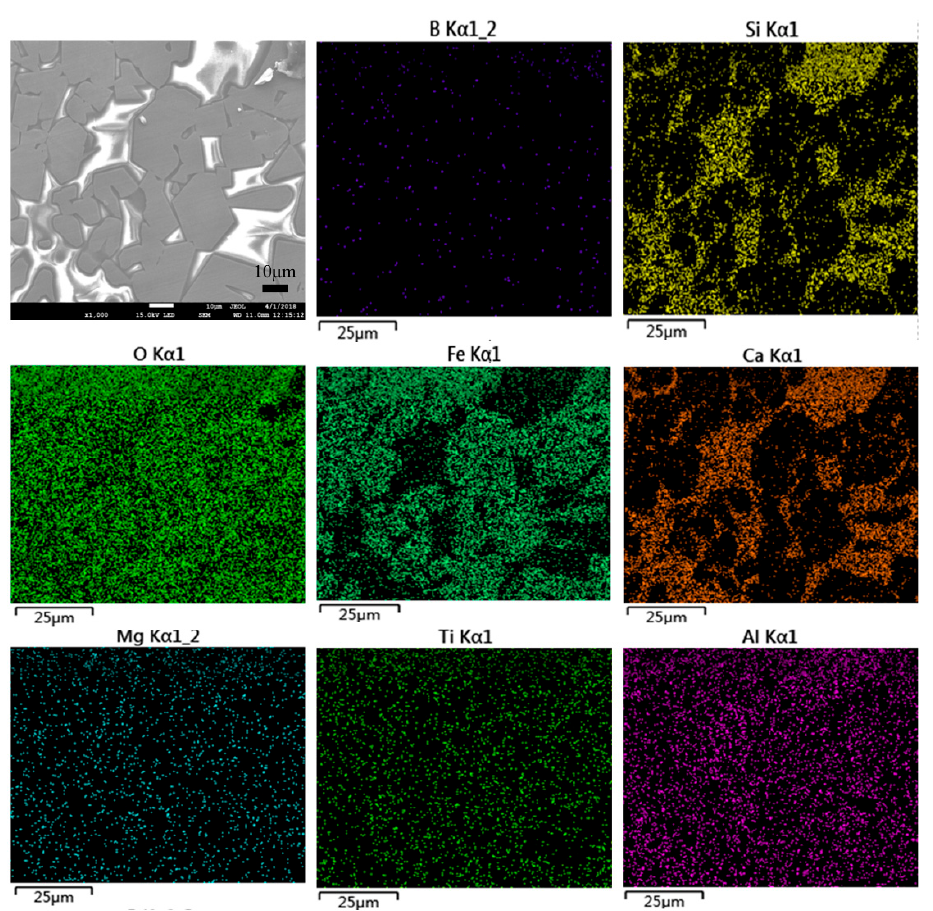
Figure 10. Surface scanning of sample with 5% B 2 O 3 added.